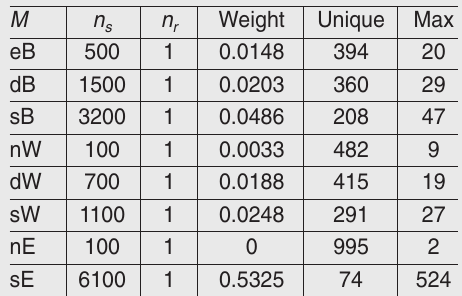
Table 2. Sampling statistics for the different models (M). The number of parameter sets in the sample (nS) and the resample (nR), the maxi- mum importance weight of a draw relative to the total importance weight of all draws, the number of unique parameter sets in the resample, and the maximum number of occurrences of a unique parameter set in the resample. nS and nR are given in thousands. eB, dB and sB are the expo- nential, density-regulated, and selection-delayed models for Baffin Bay walruses. nW, dW and sW are the density-regulated (no age data), density regulated, and selection-delayed models for West Greenland/Baffin Island walruses. nE and sE are the density-regulated (no age data) and selection- delayed models for East Greenland